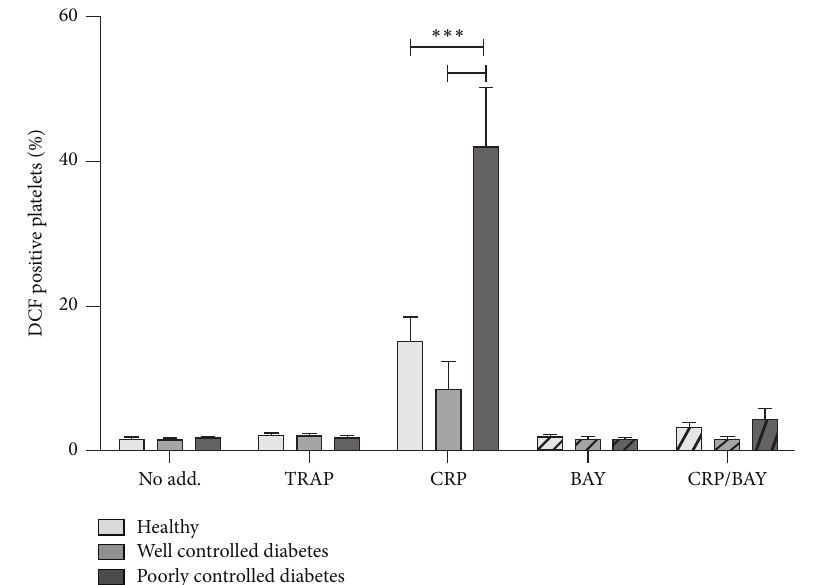
Figure 2: Effect of well-controlled or poor glycaemic control on intracellular ROS measurements in diabetes. Flow cytometry of H 2 DCF-DA- loaded monkey platelets in PRP either untreated (no add.) or treated with 10 𝜇 g/mL CRP or 5 𝜇 M TRAP. Syk inhibition by 5 𝜇 M BAY61-3606 (BAY) reduces GPVI-induced ROS generation in all monkey groups. Data are from six monkeys in each group. ∗∗∗ 𝑃 < 0.001